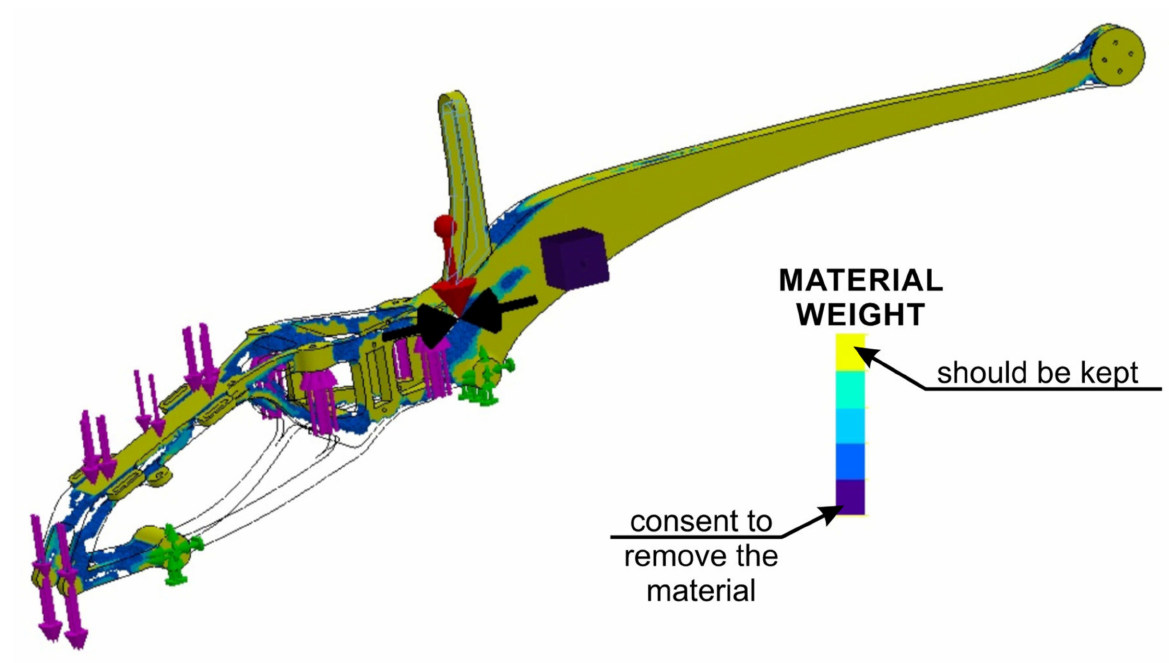
Figure 18. Results of the topological optimization